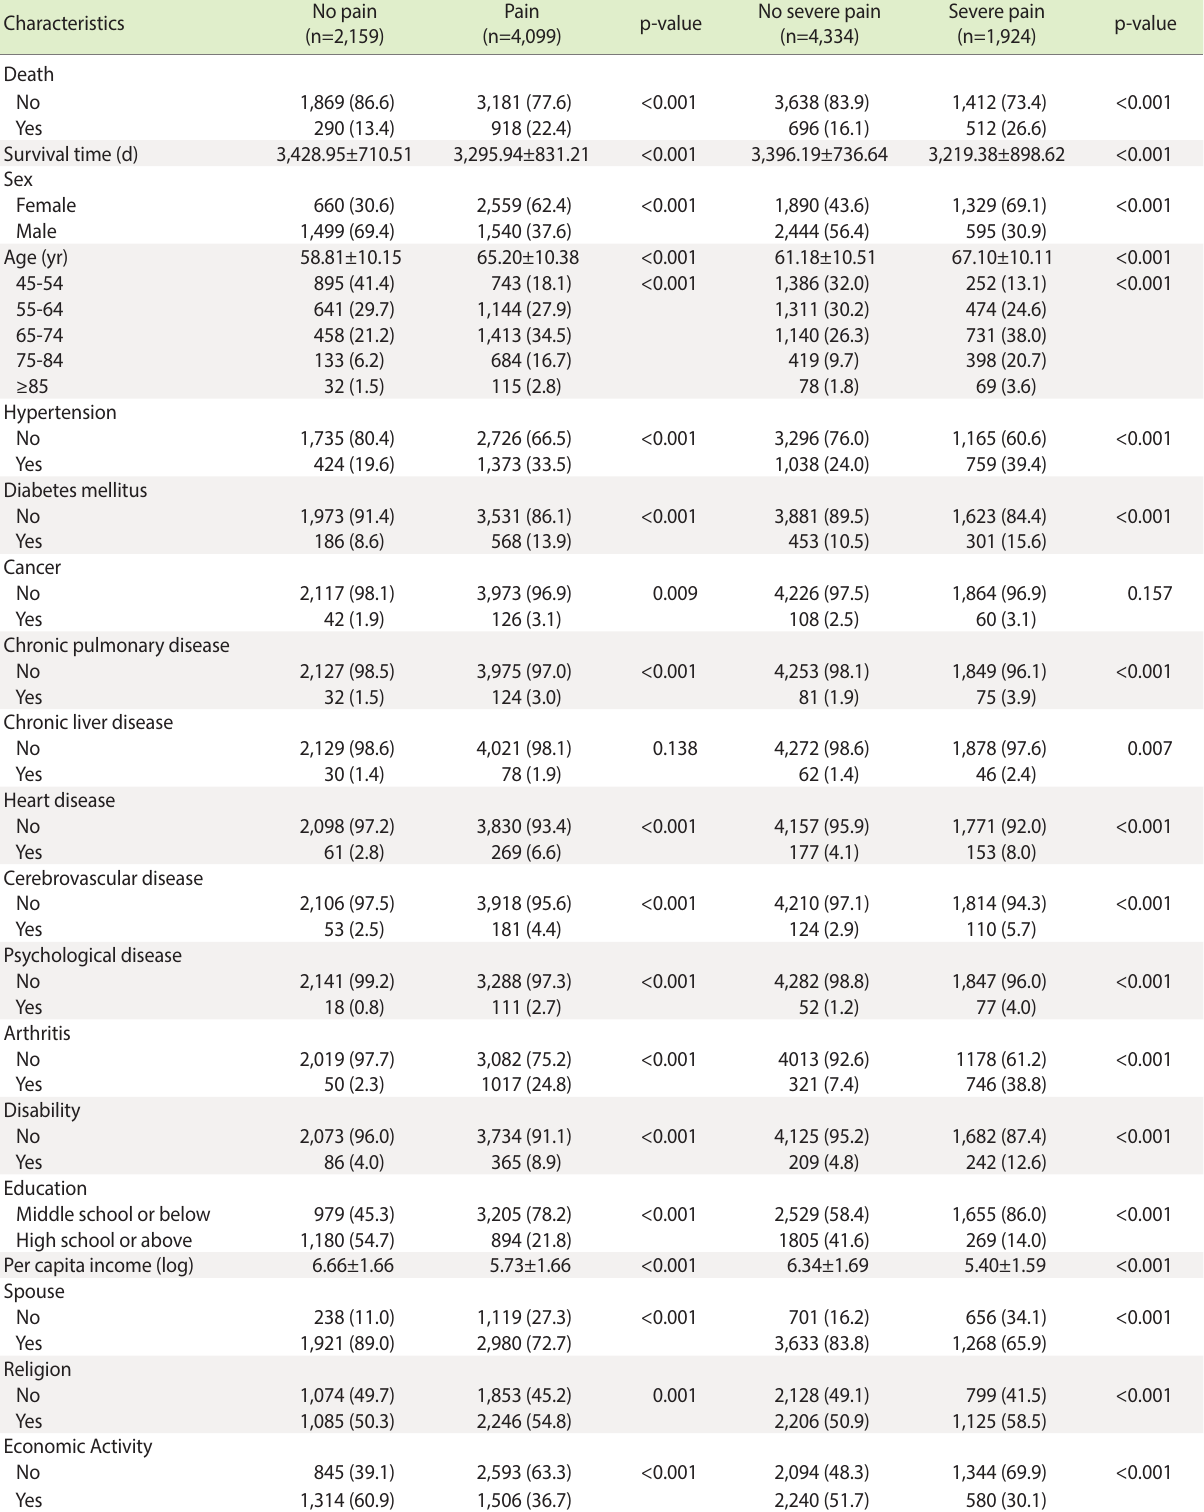
Table 1. Sample characteristics at baseline in 2006